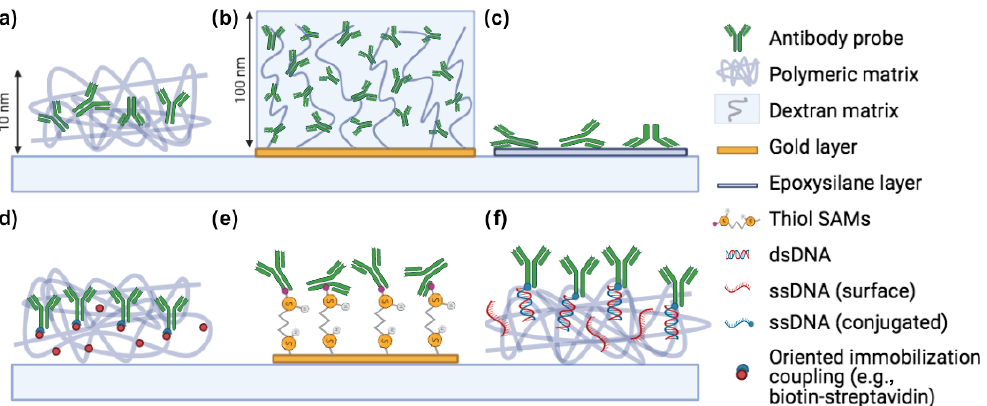
Figure 1. Common immobilization methods for microarray applications. ( a ) Copoly(DMA-NAS-MAPS), ( b ) Carboxymethyl dextran, ( c ) Epoxysilane, ( d ) Oriented immobilization (biotin-streptavidin, click chemistry), ( e ) Thiol-gold coupling, ( f ) DNA- directed immobilization. Created with Biorender.com, accessed on 1 January